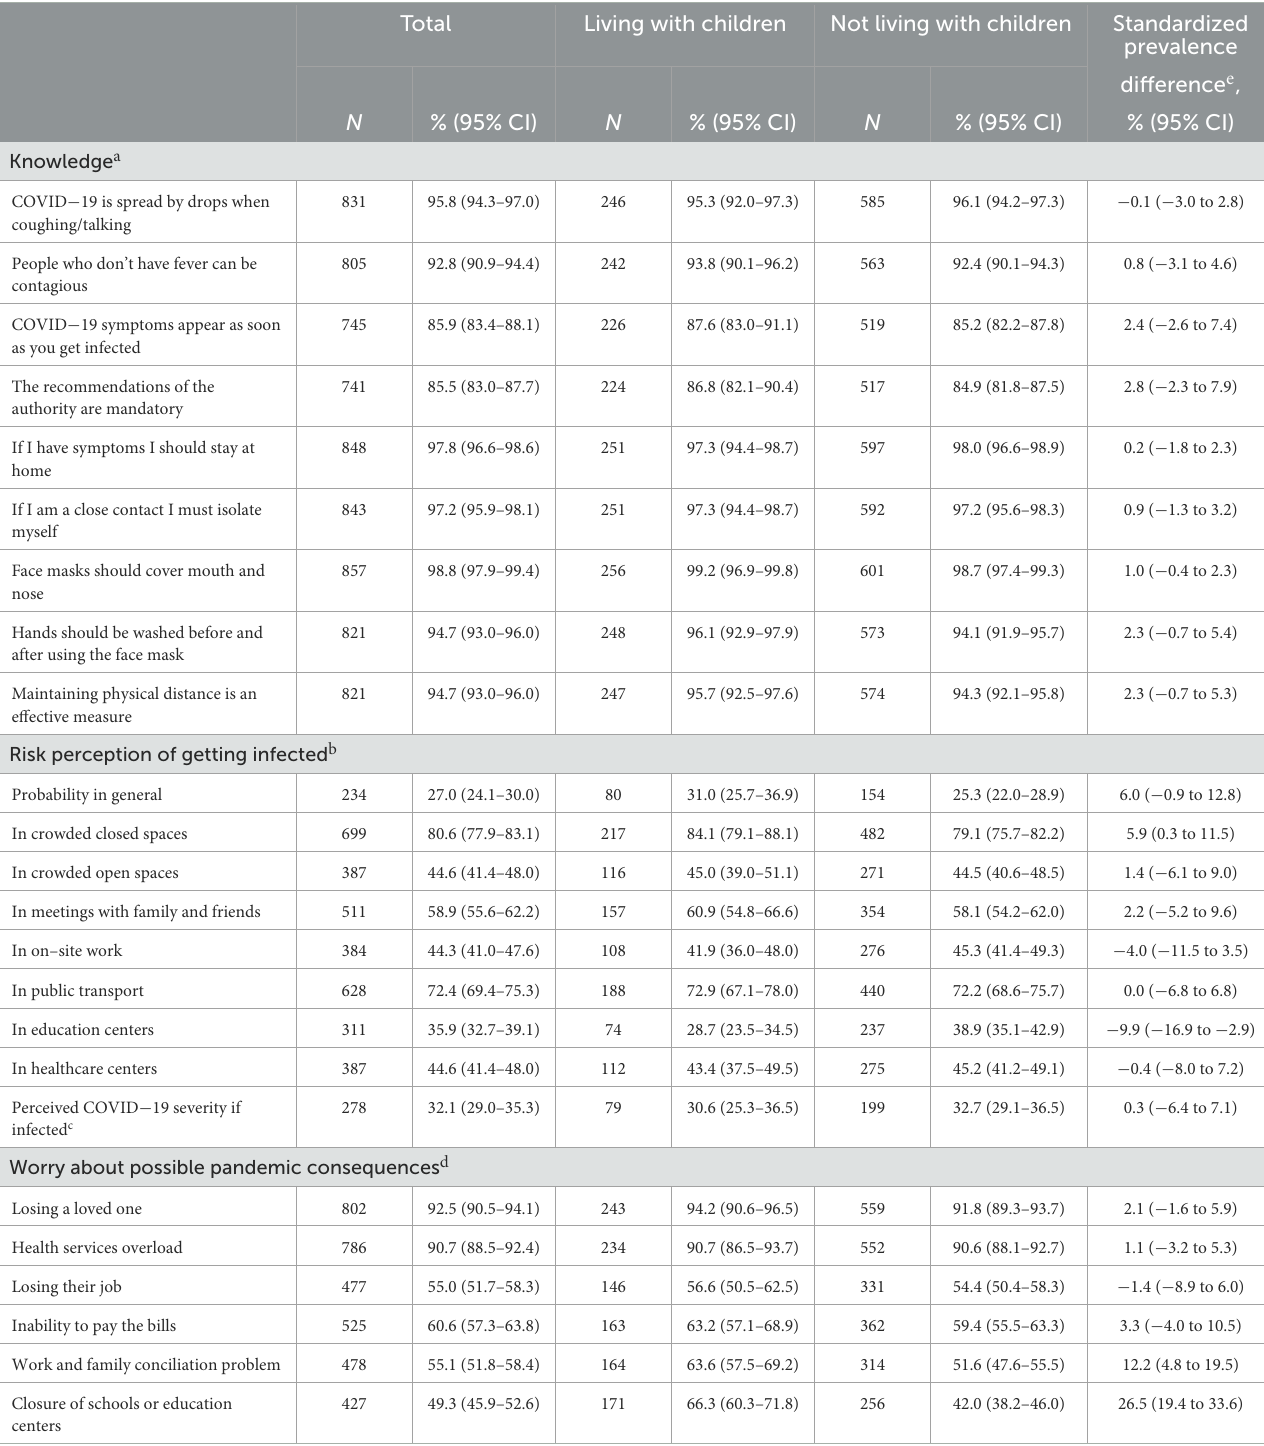
TABLE 4 Knowledge, risk perception and worries on COVID-19 in the COSMO-SPAIN participants, according to presence of children in the household, November 2020. Total Living with children Not living with children Standardized